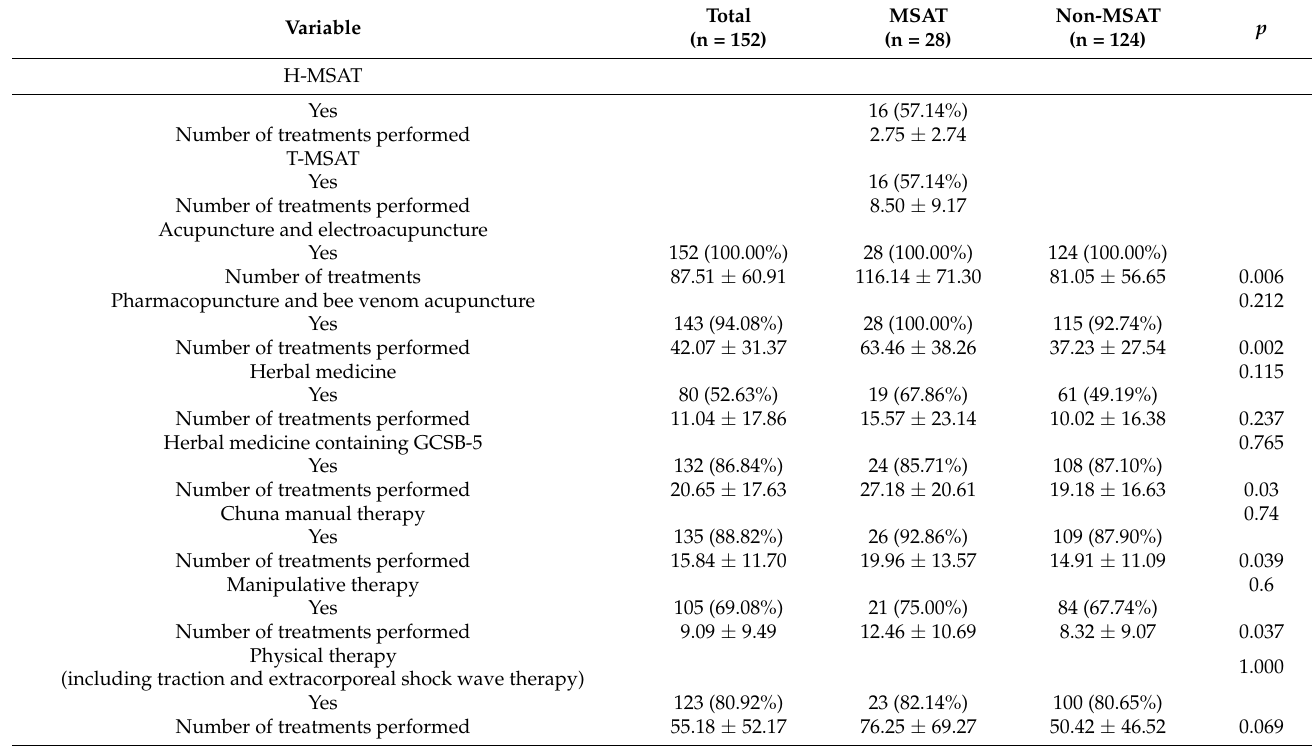
Table 2. History of treatment during hospital